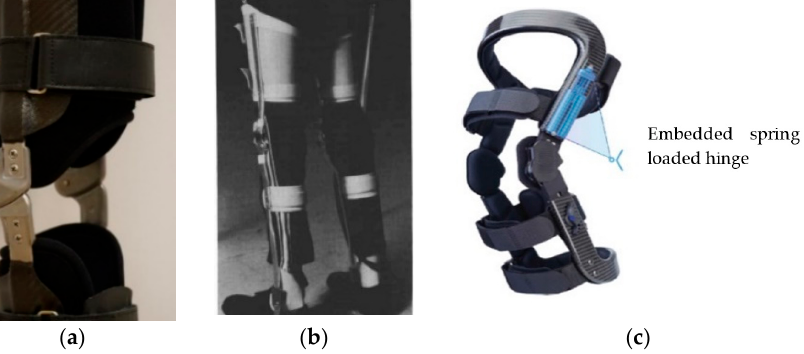
Figure 3. Knee orthoses: ( a ) A free knee joint with posterior axis [13], ( b ) Bilateral orthosis [14], ( c ) Tricompartmental Offloading Knee Brace (TCO) with spring hinge [15].